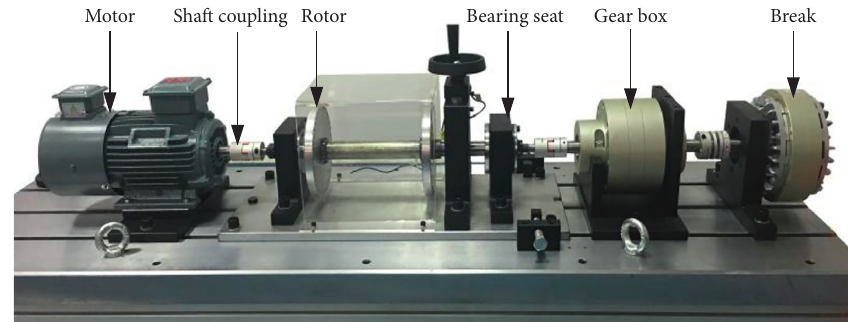
Figure 8: Rotating machinery fault diagnosis experimental device of SDUST.